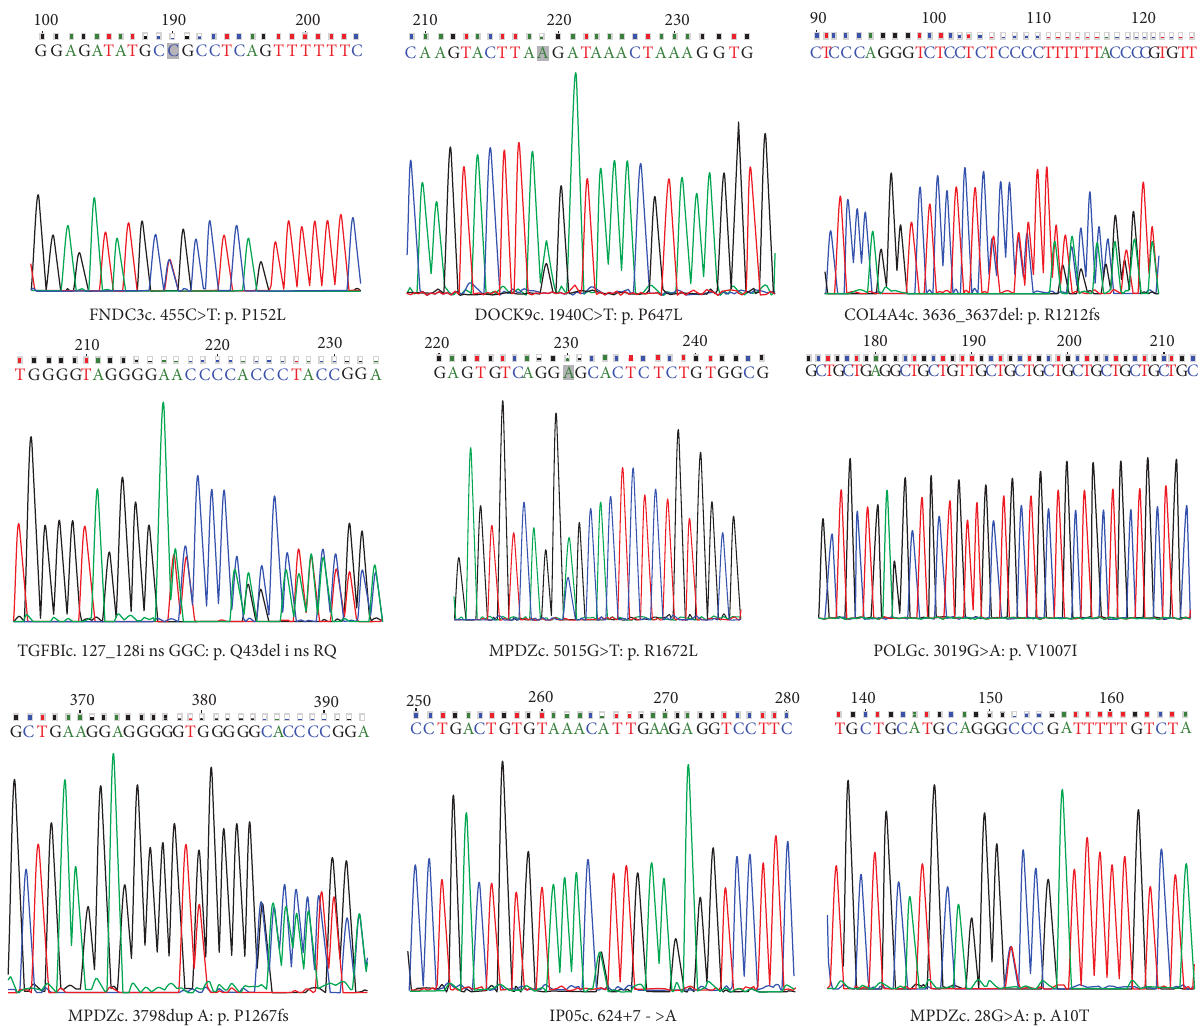
Figure 1: Sequence chromatogram of the nine novel mutations. Table 3: The characteristics of 8 patients carrying the nine novel